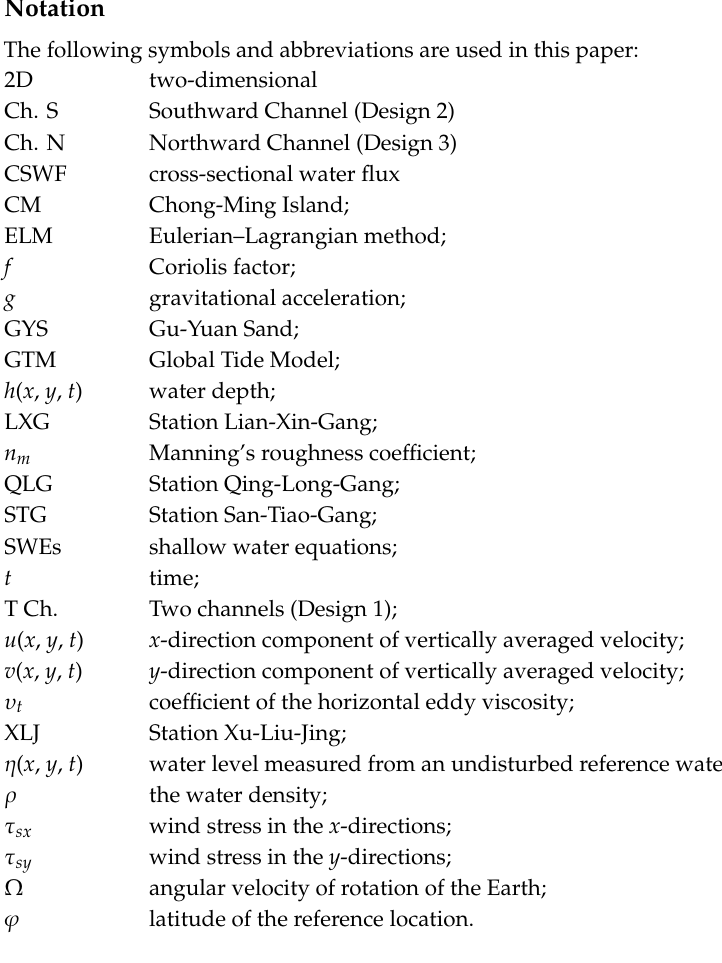
Figure S1: Channel-refined computational grid for numerical model of Yangtze